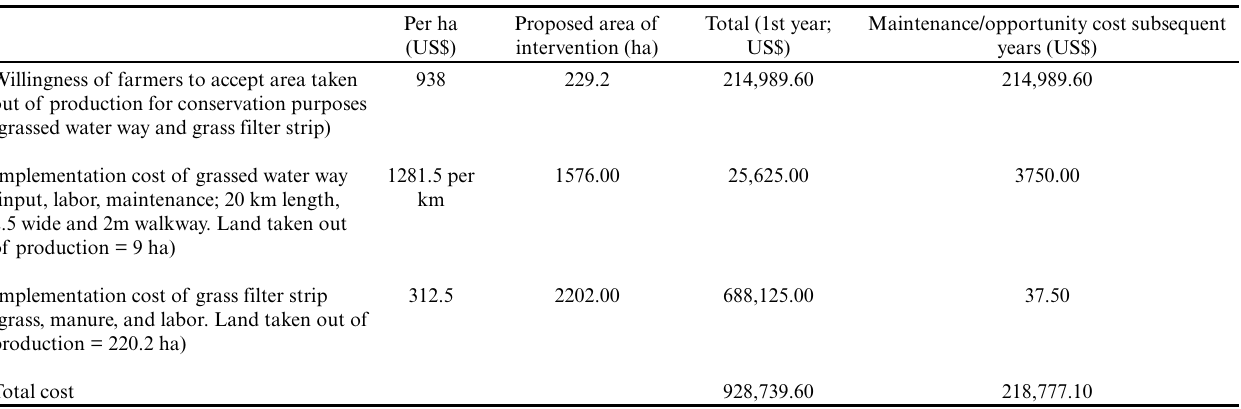
Table 8 . Costs of implementing payments for ecosystem services (PES) measures †